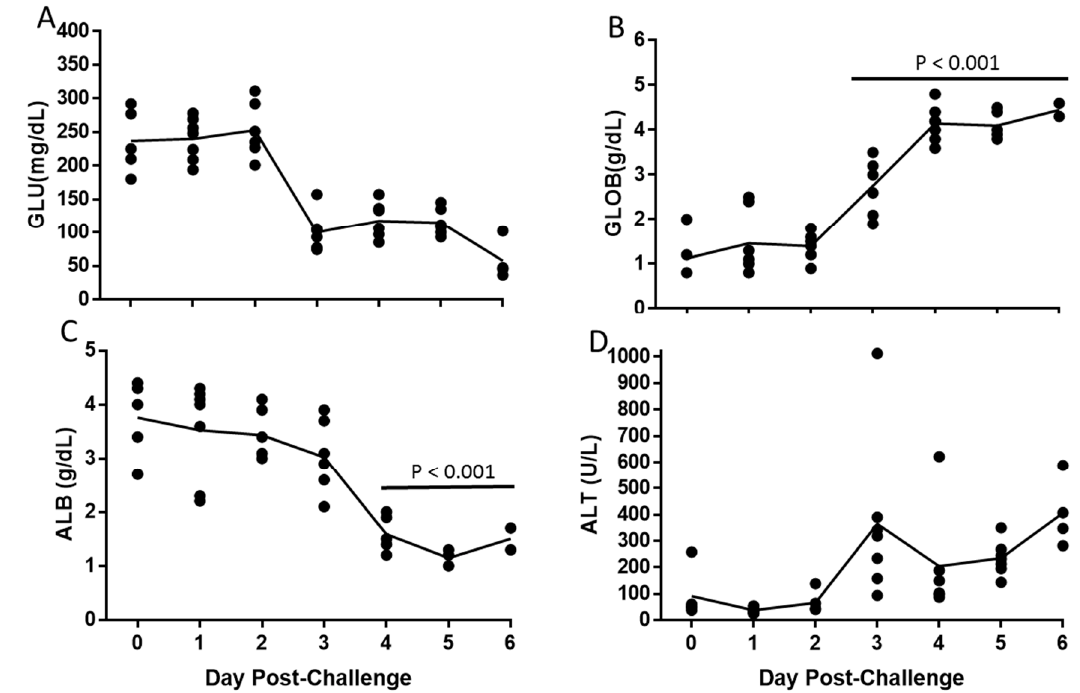
Figure 5. Changes in Serum Chemistry following EBOV Challenge. Symbols ( • ) represent values for individual mice and the line represents means of: Glucose (GLU; A ), Globulin (GLOB; B ), Albumin (ALB; C ), and Alanine aminotransferase (ALT; D ). Horizontal bar indicates significant difference from Day 0.